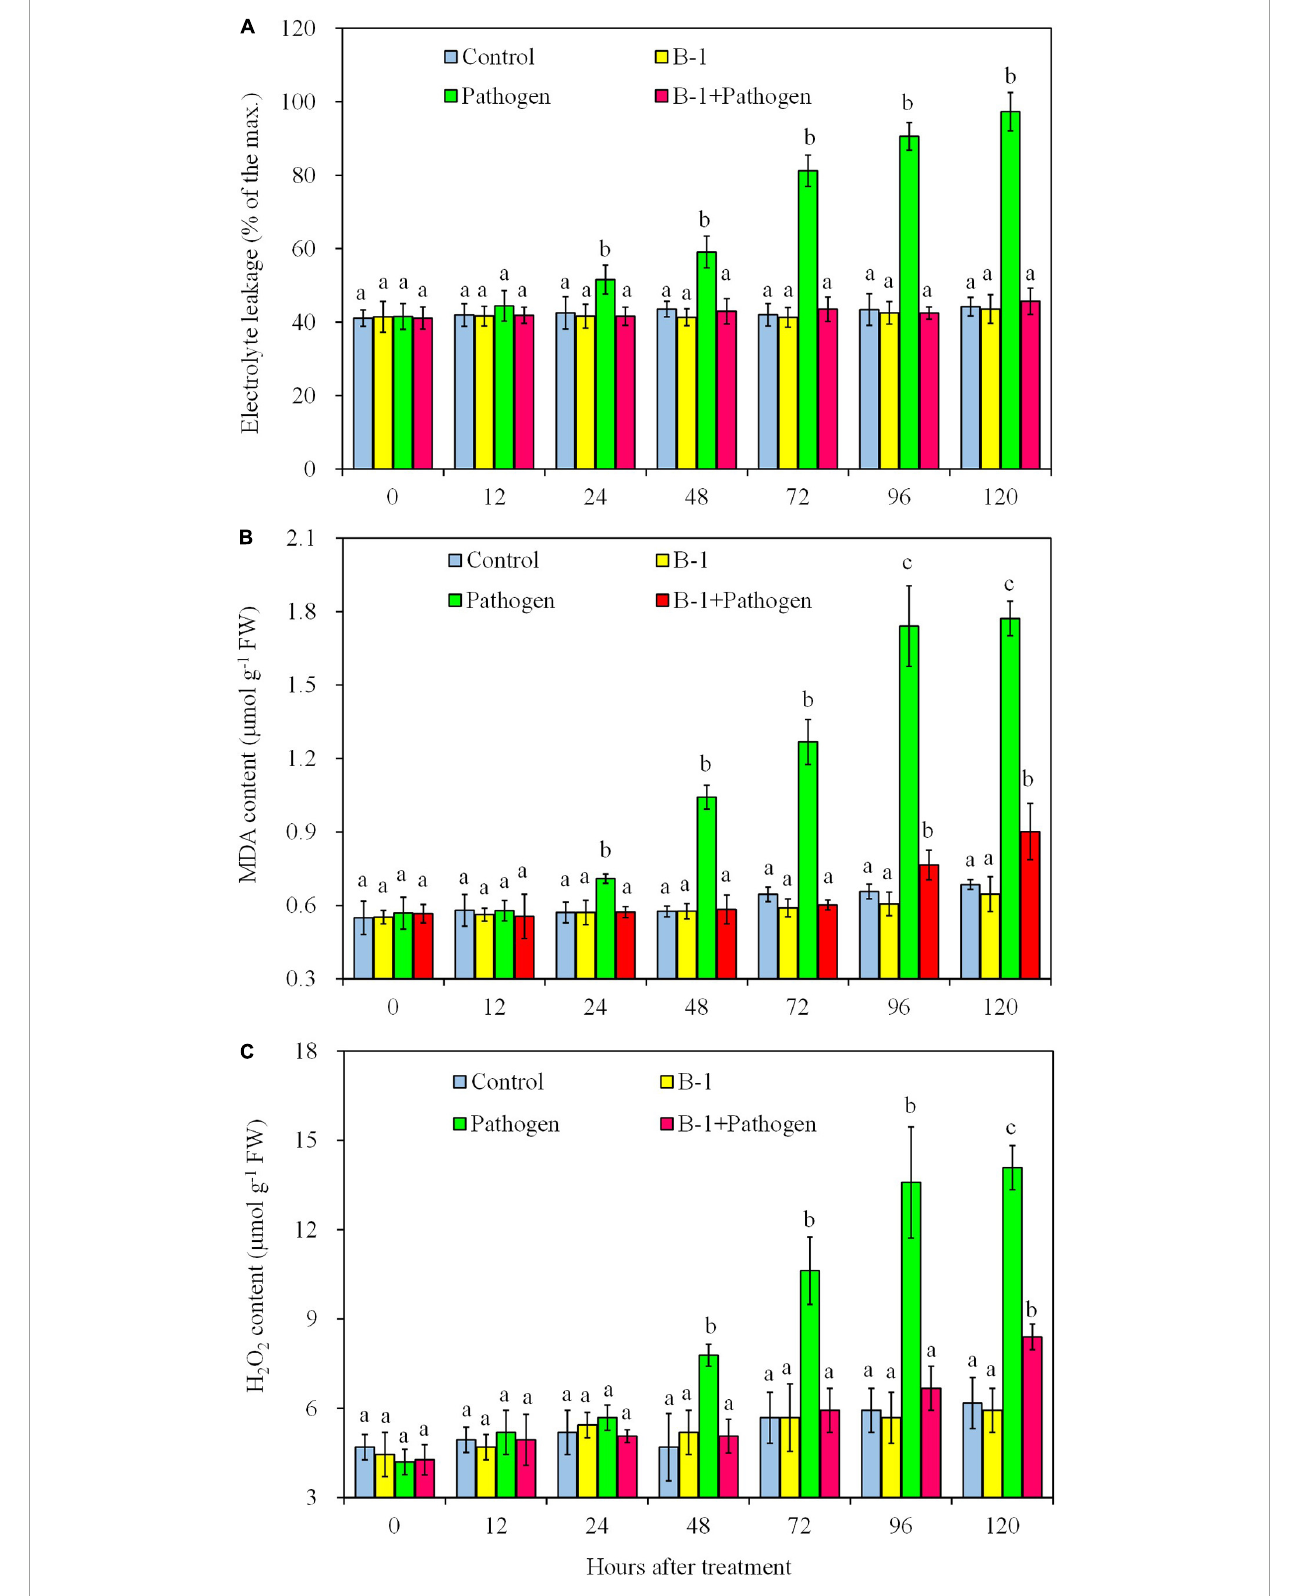
FIGURE4 The electrolyte leakage (A) , MDA content (B) , and H 2 O 2 content (C) in apple fruit with four treatments stored at 25 ◦ C. Each data represents the mean ± SD of three replicates. Different letters above the bars indicate significant differences ( p < 0.05) at the same time